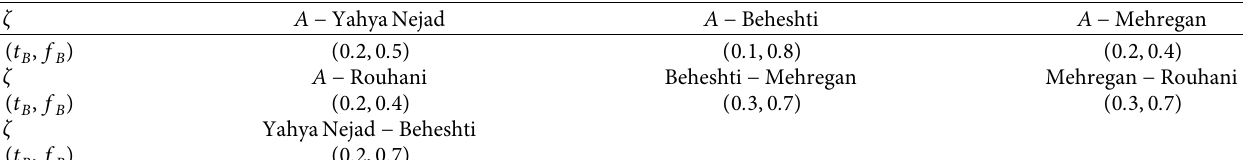
Table 3: Weight of